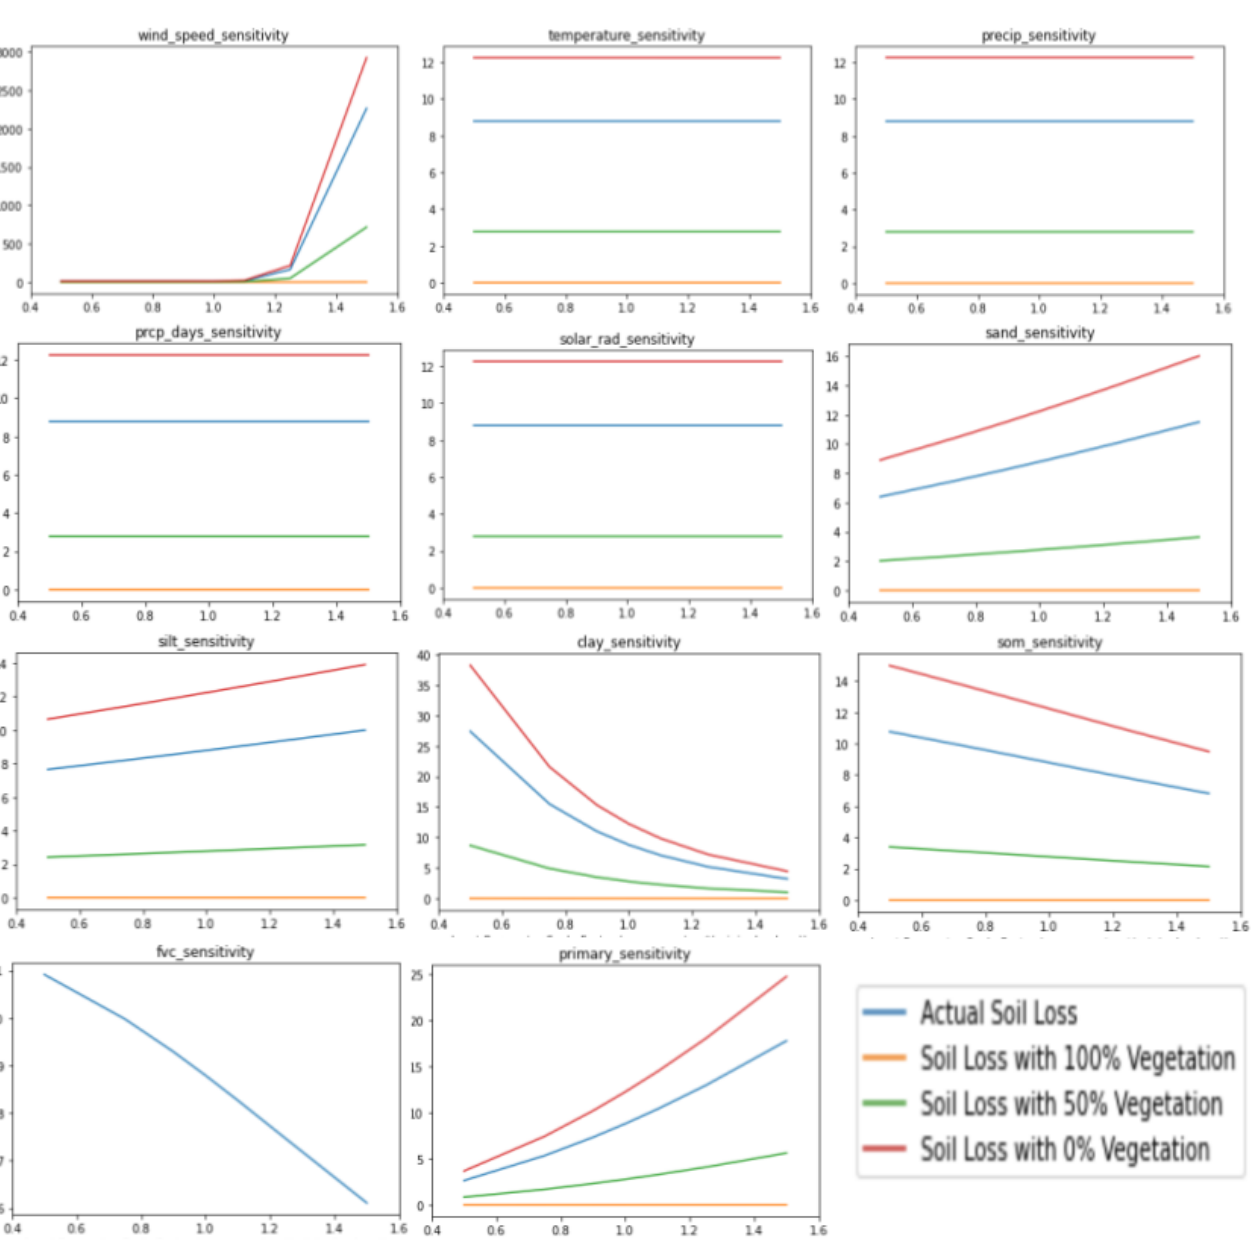
Figure 5. Plots of sensitivity of soil loss to model inputs. The sensitivity of soil loss was plotted against scenarios of 0%, 50%, 100%, and original vegetation coverage. The y -axis represents soil loss in kg/m 2 and the x -axis represents the scale parameter that multiplies the input (e.g., 0.5 for